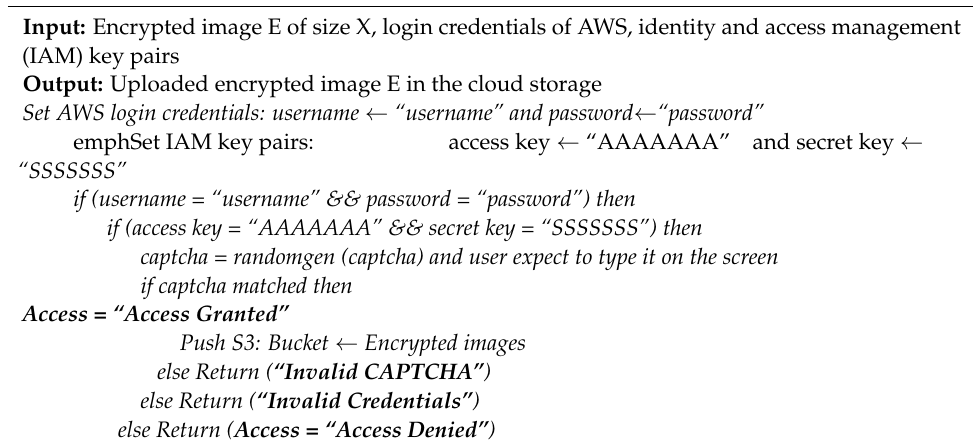
Algorithm 5: Authenticated cloud access